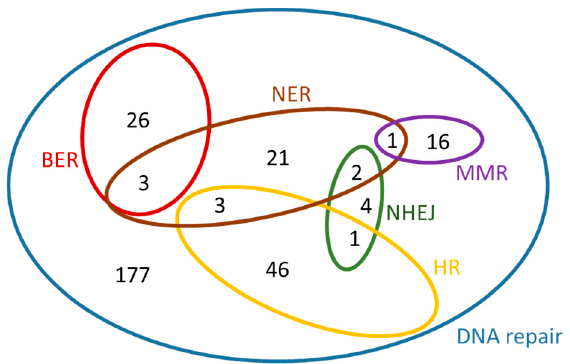
Figure 6. Venn diagram of the Arabidopsis thaliana genes that were found under each of the GO terms listed in Table 4.